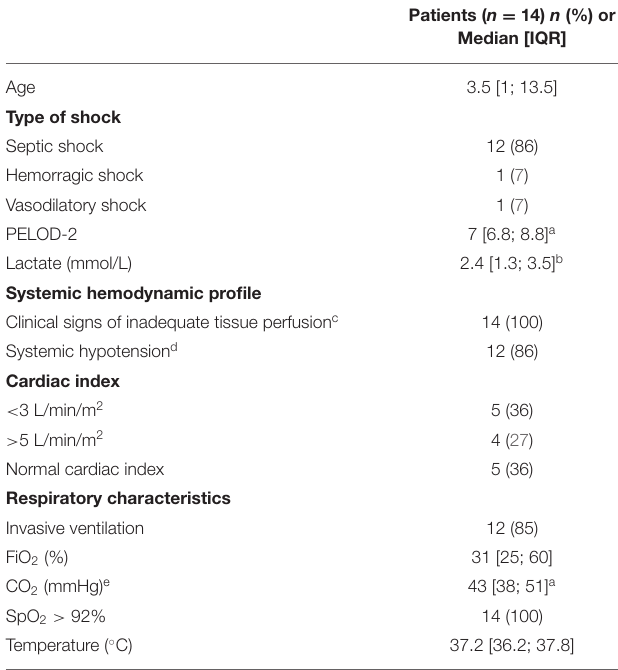
TABLE 1 | Patients baseline